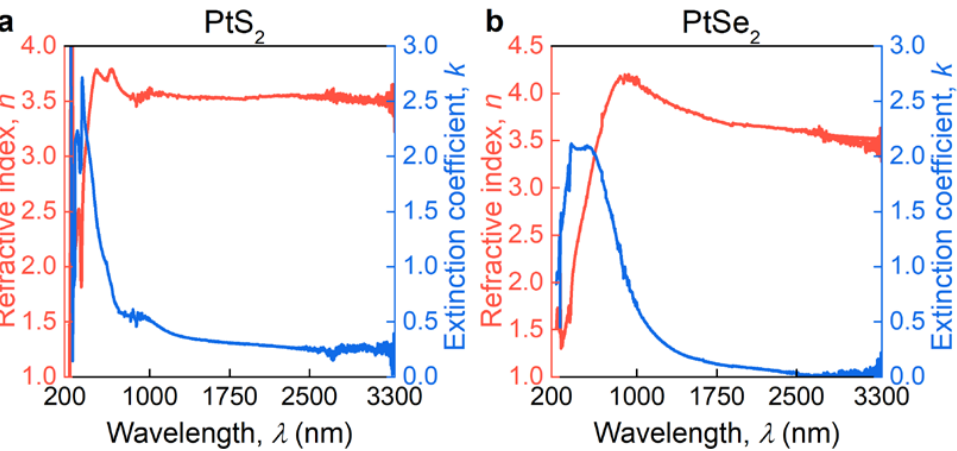
and . Direct inversion of 𝛹𝛹 𝛥𝛥